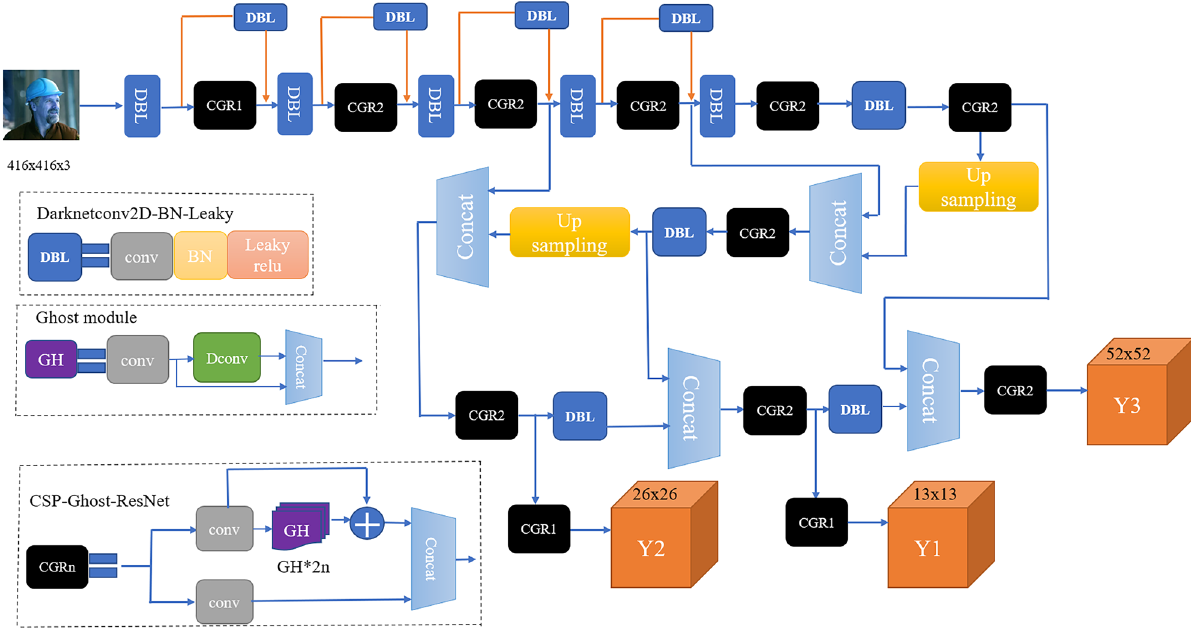
Figure 4. The ML-YOLOv3